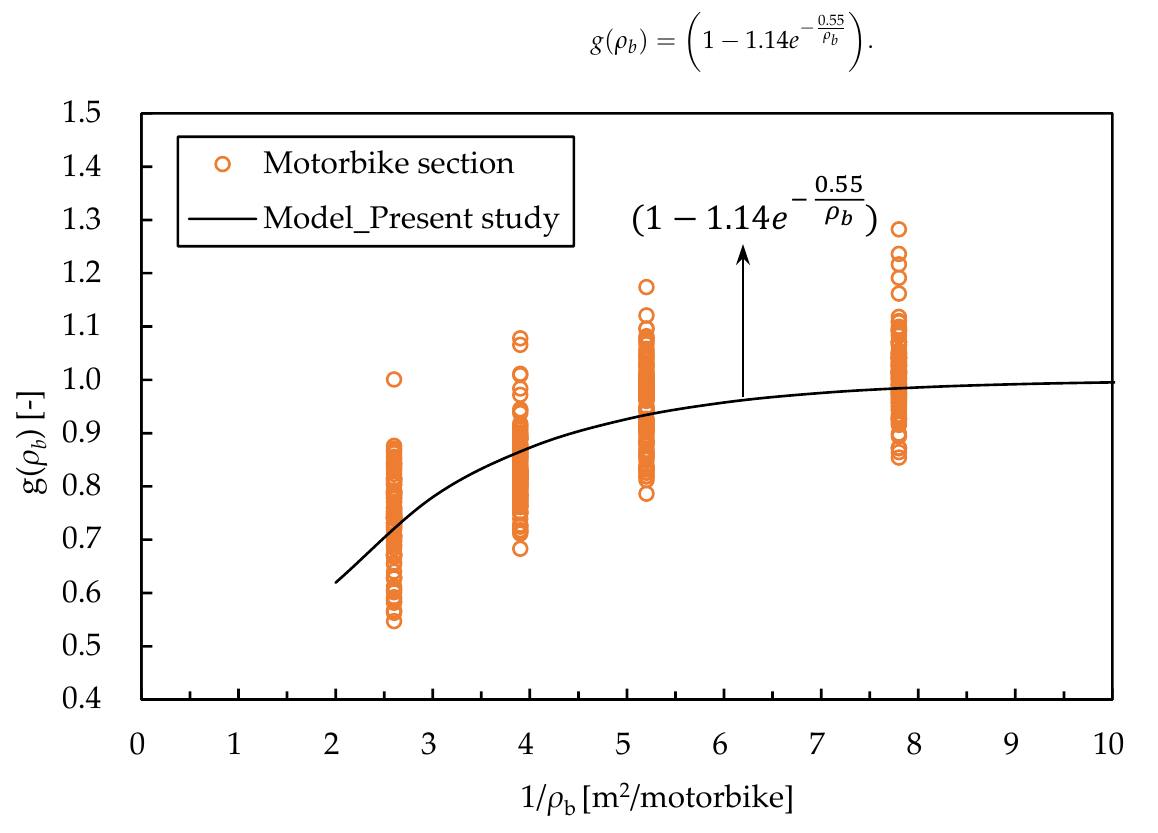
Figure 12. Relationship between g(ρ b ) and motorbike density (ρ b ).